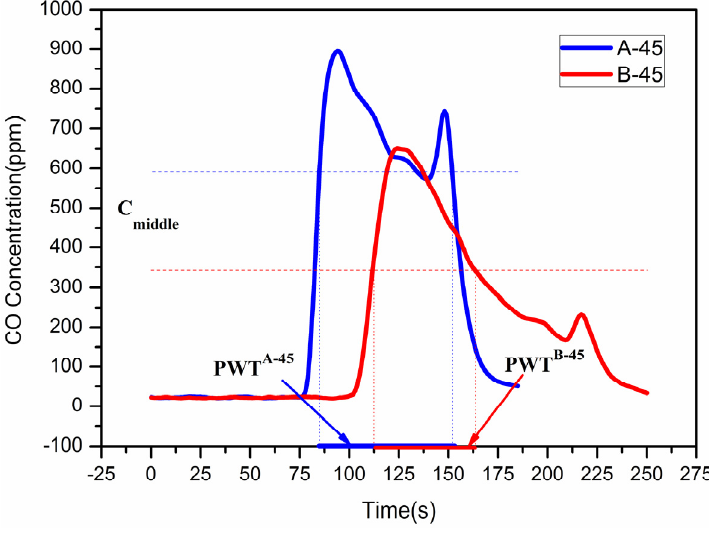
Figure 12. CO concentration generated by material A and B when heat flux is 45 kW/m 2 .